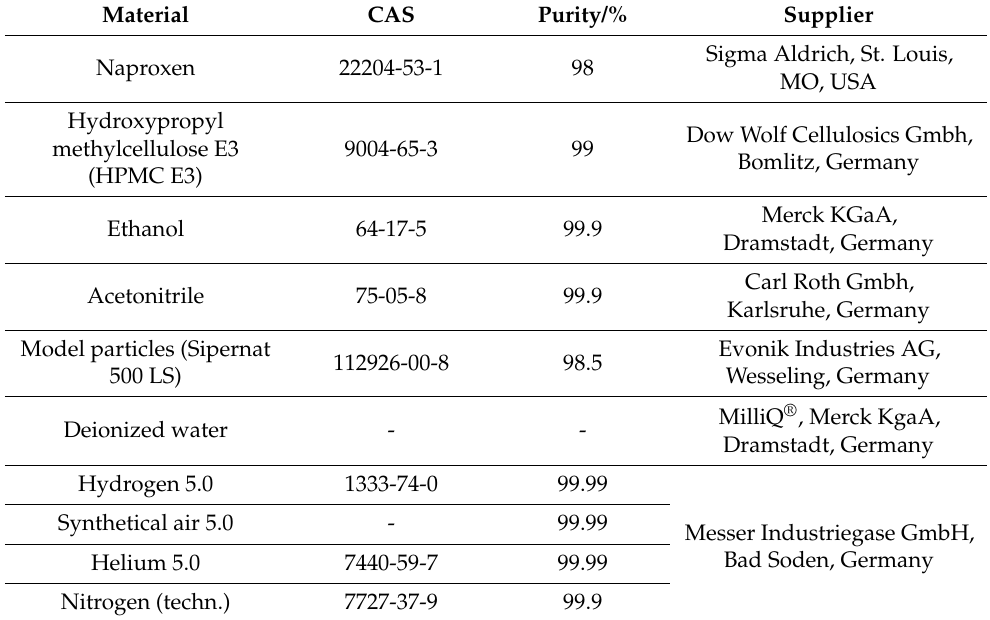
Table 1. List of materials used in this study with chemical abstract service (CAS) number, purity, and supplier information.